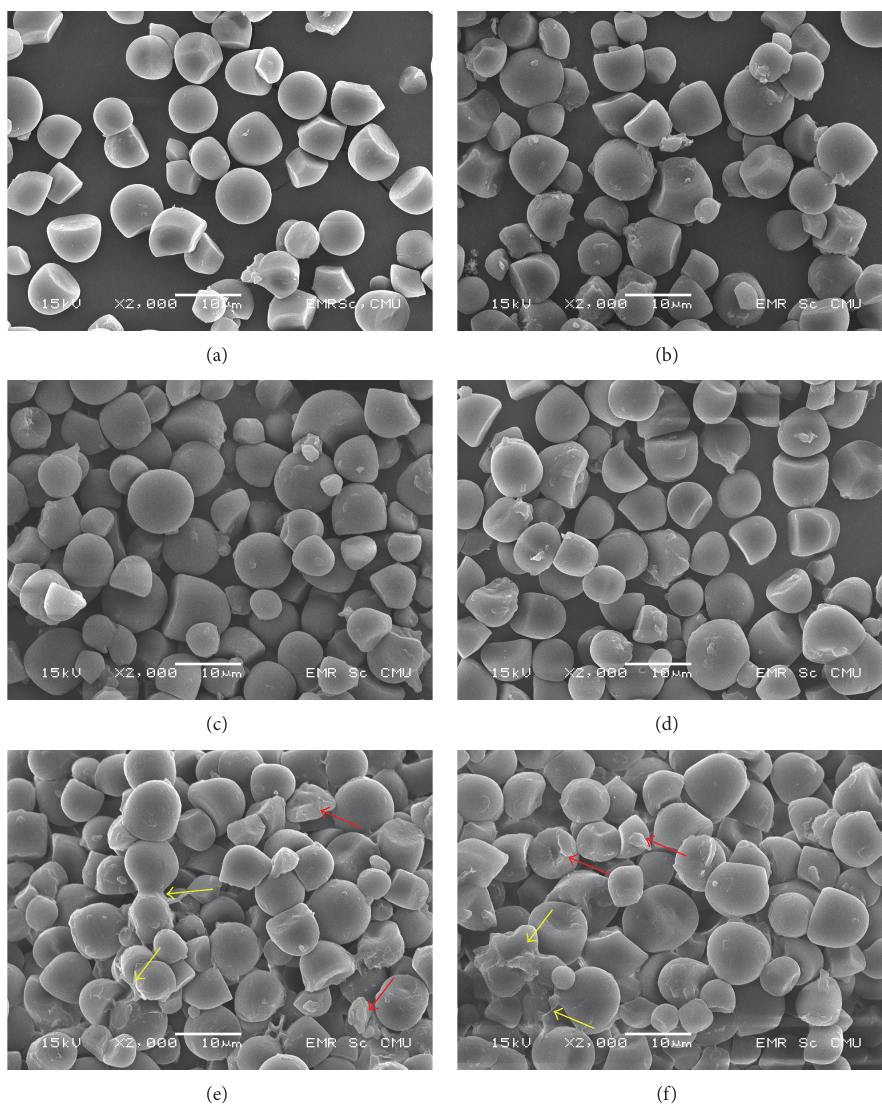
Figure 3: Scanning electron microscopic (SEM) images of JFS and representative HMT-JFS. (a) Native JFS, (b) JF-N-80-6, (c)